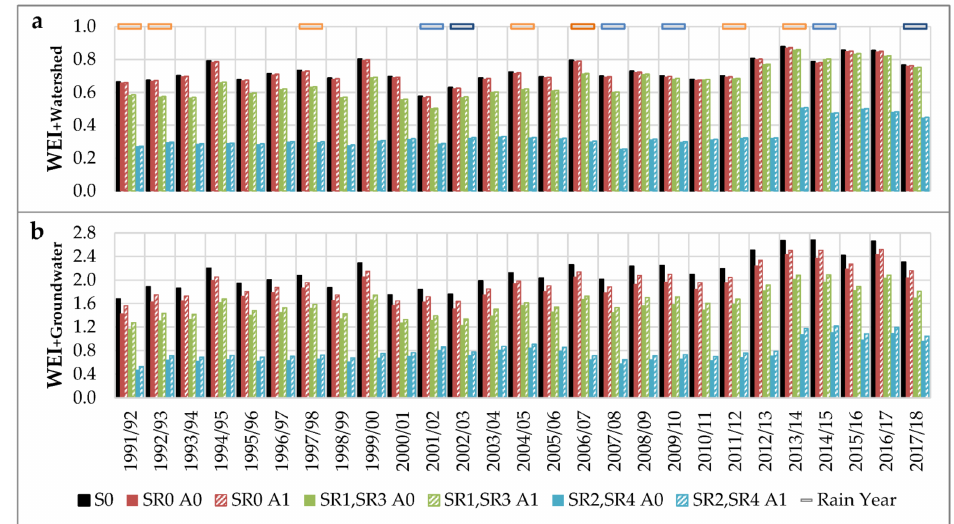
Figure 10. Annual values of ( a ) Basin Water Exploitation Index (WEI +Watershed ) and ( b ) Aquifer Water Exploitation Index (WEI +Groundwater ).